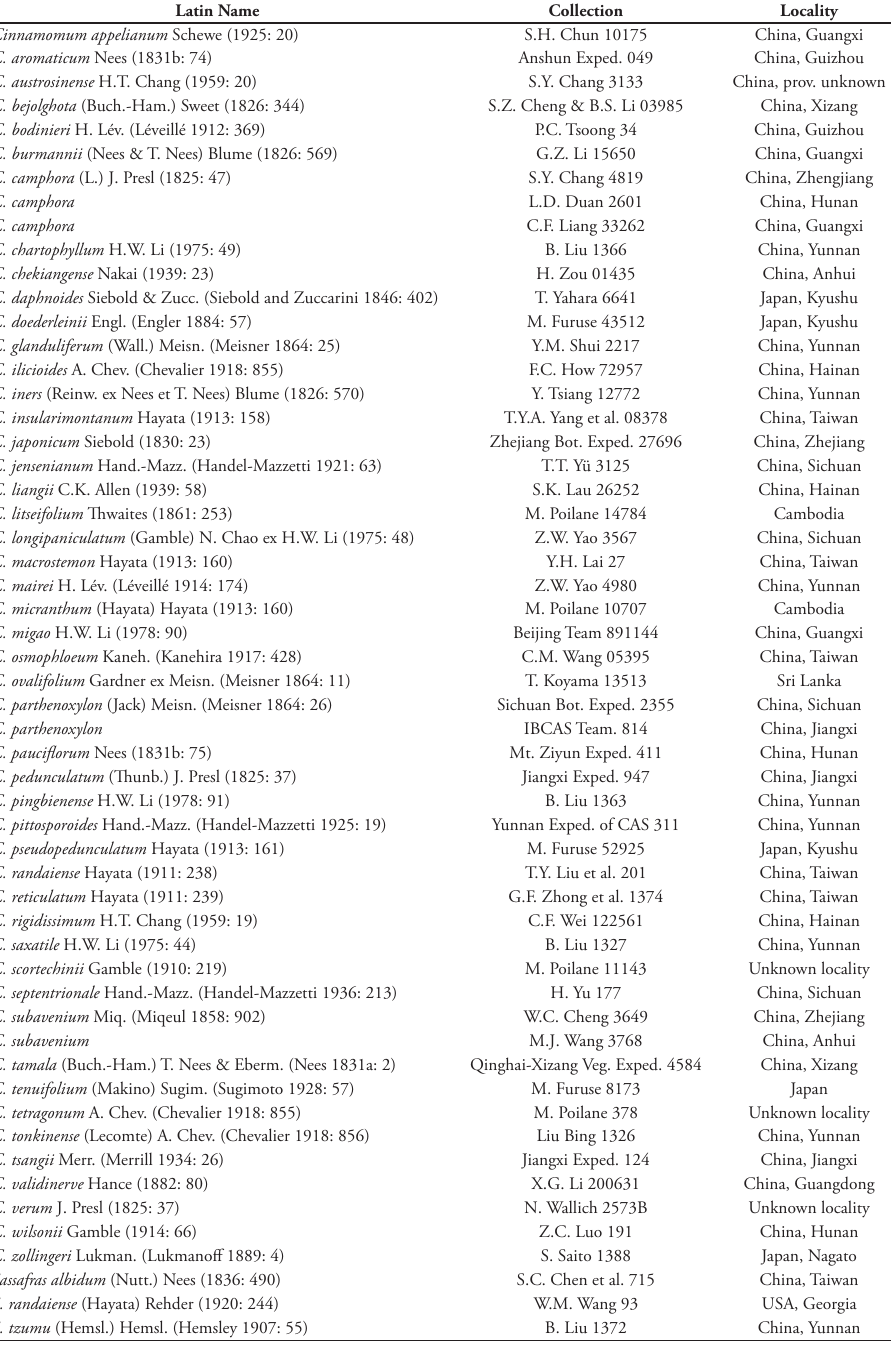
Table 1. Voucher information of leaf samples for this